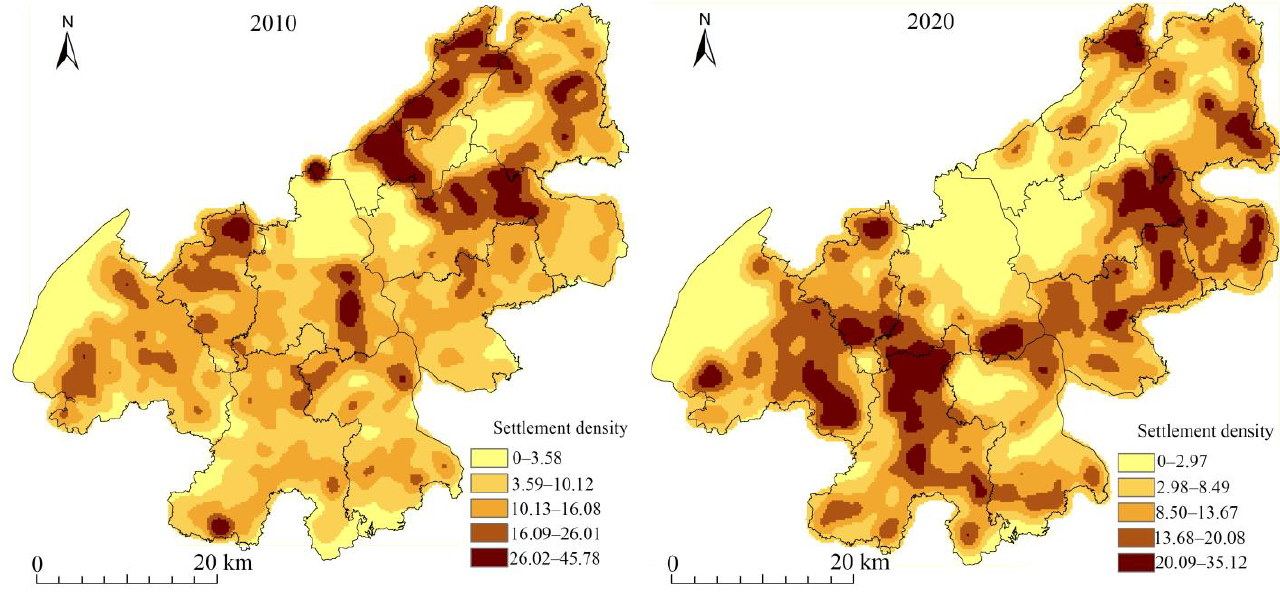
Figure 5. Density distribution of rural settlements in Jiangning from 2010 to 2020.